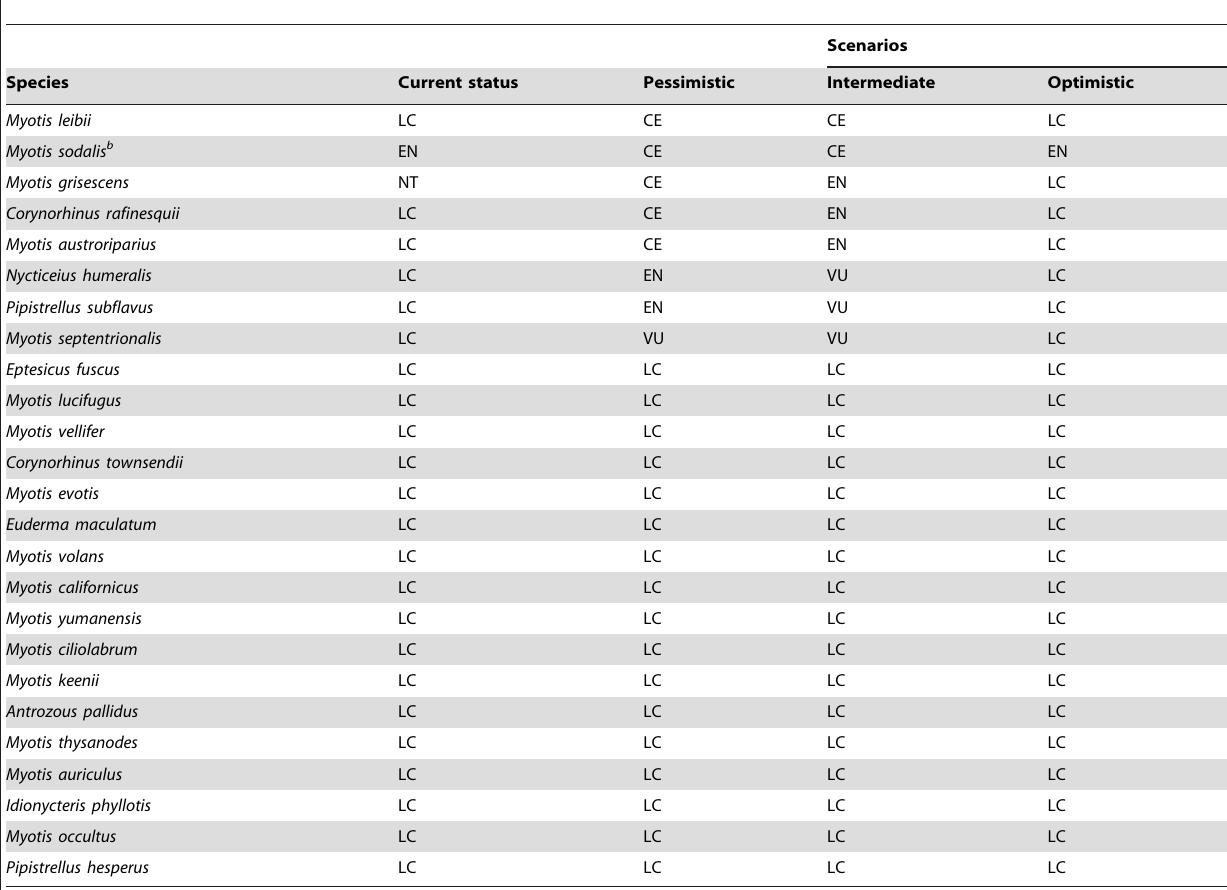
Table 2. The expected conservation status of the North American bats susceptible to White-Nose syndrome spread according to the population-reduction scenarios of Table 1 and the IUCN a